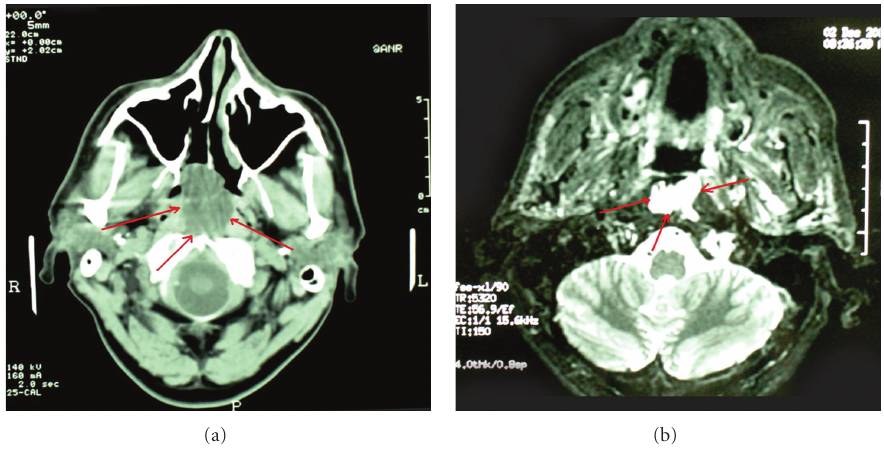
Figure 2: CT (a) and MRI (b) imaging of the tumor (red